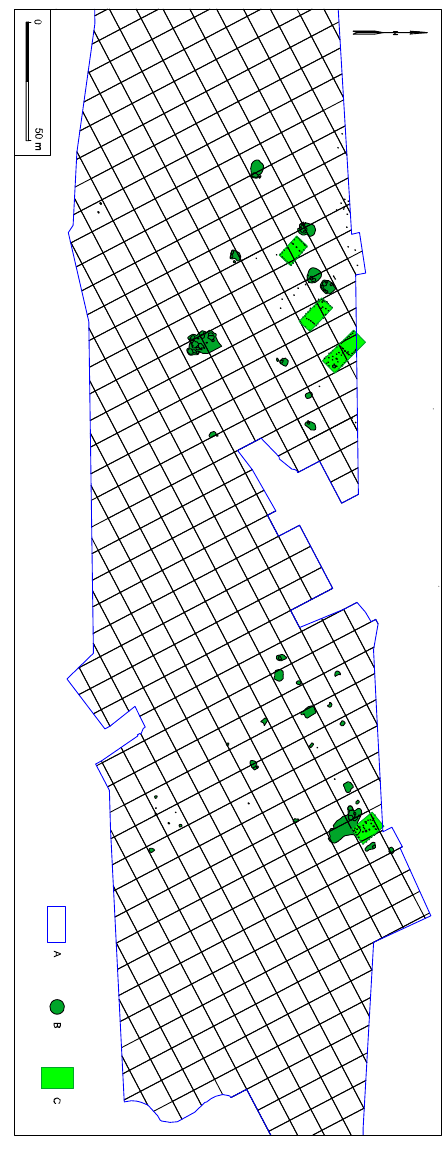
houses ( drawn by P. Kalka )